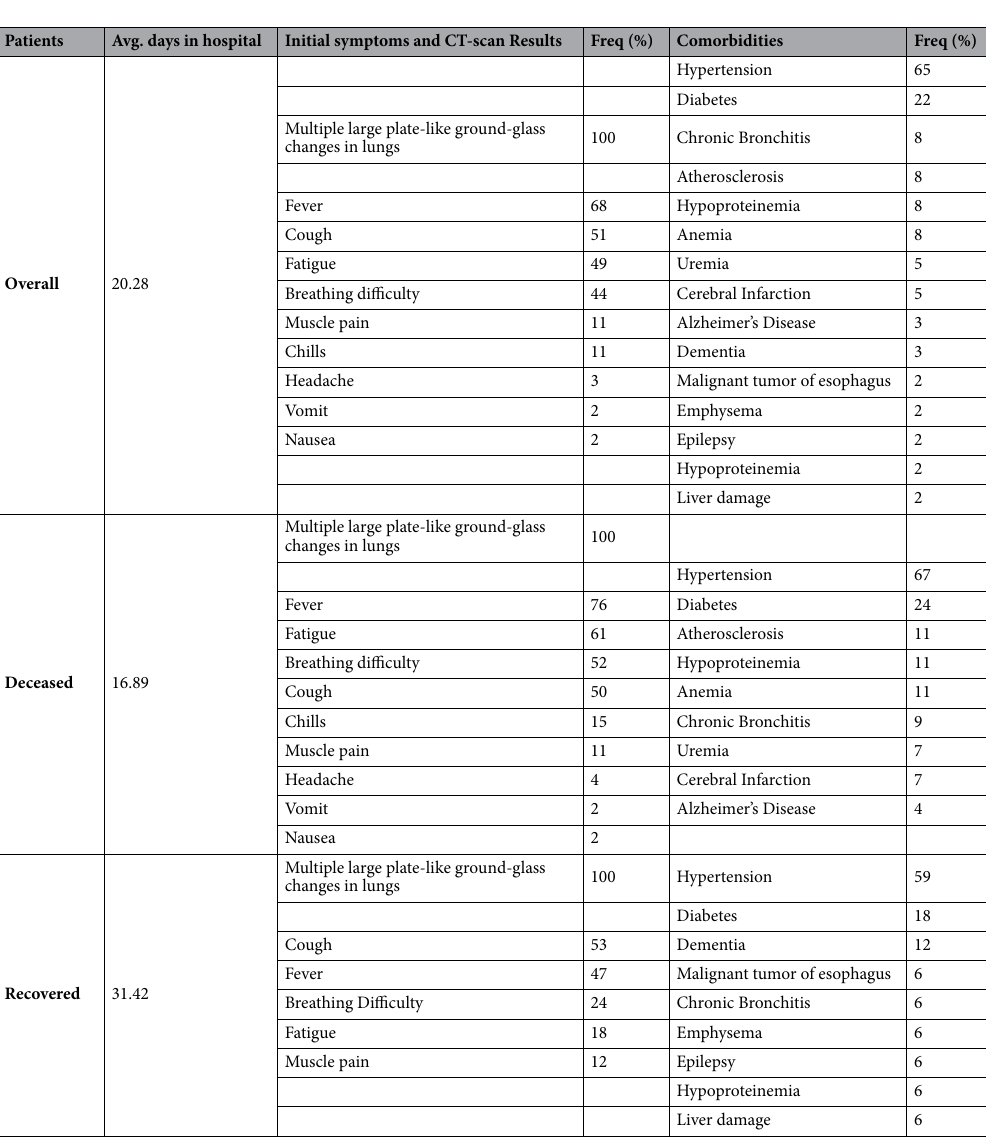
Table 2. Initial symptoms, comorbidities and CT-scan results of COVID-19